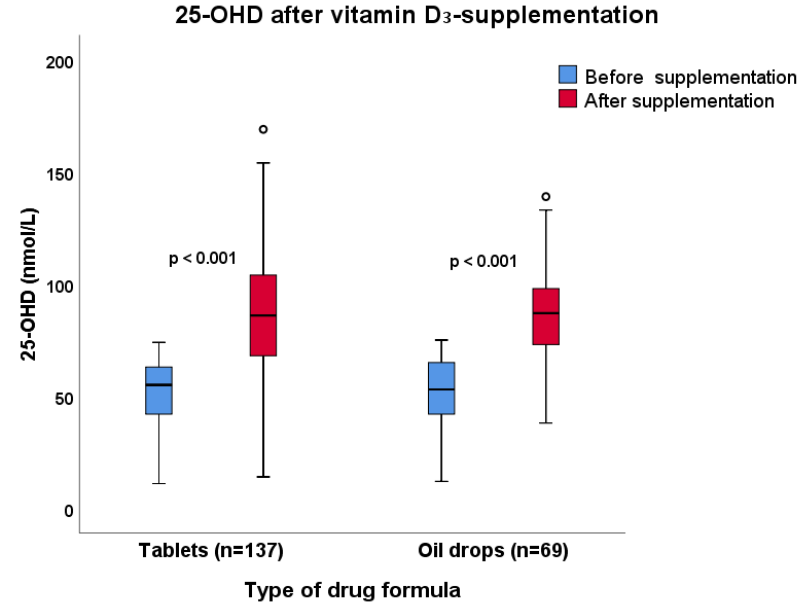
Figure 3. Outcome for S-25-hydroxyvitamin D (S-25-OHD) concentrations in immunodeficient patients receiving vitamin D 3 supplementation as oil drops (1500 IE / day) or as tablets (1600 IE / day) for 3–5 months. Median S-25-OHD increased from 55 to 86 nmol / L in the group taking oral drops and from 53 to 87 nmol / L in the group taking tablets. There was no di ff erence in the increase in S-25-OHD from baseline between the groups (Mann–Whitney U test, p =